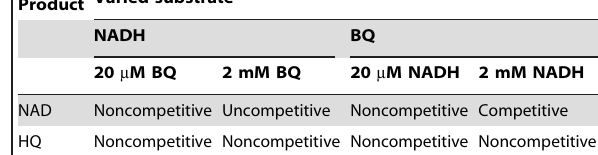
Table 2. Product Inhibition a .